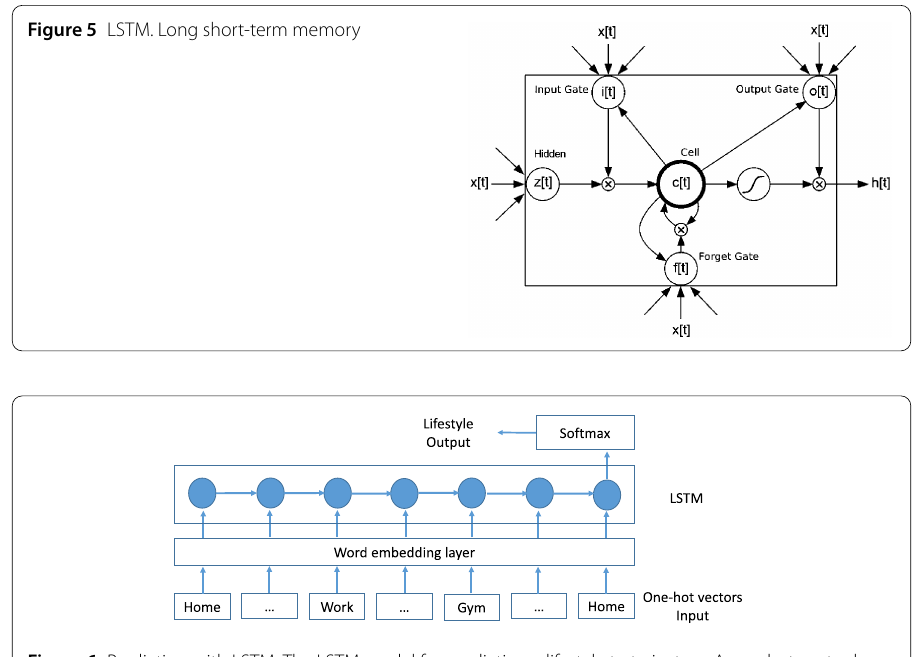
Figure 5 LSTM. Long short-term memory